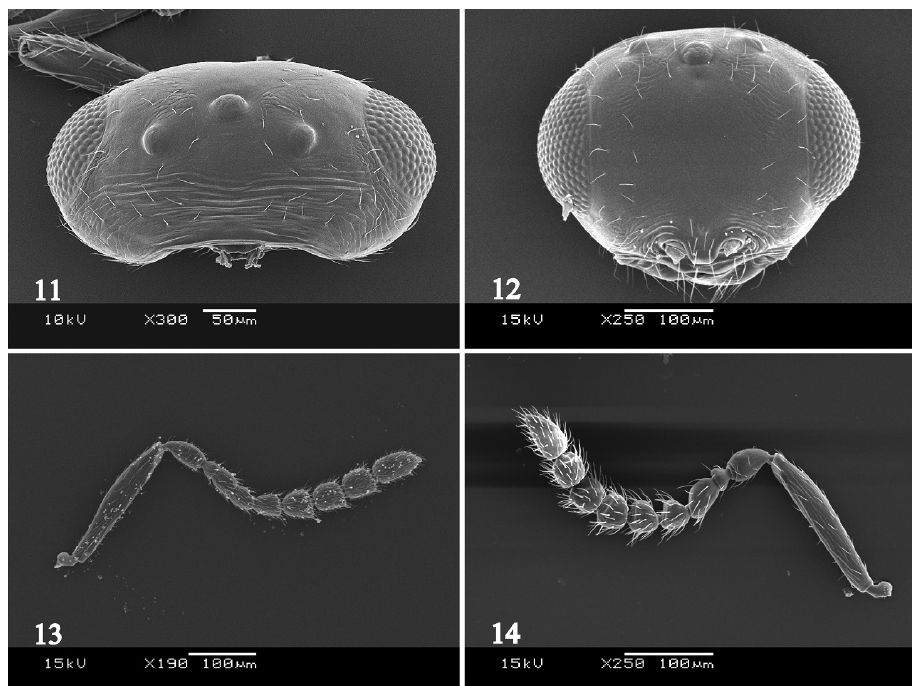
Figure 11–14. Platygaster urniphila . 11 female head, dorsal view 12 female head, frontal view 13 female antenna 14 male antenna. Scale bar 100